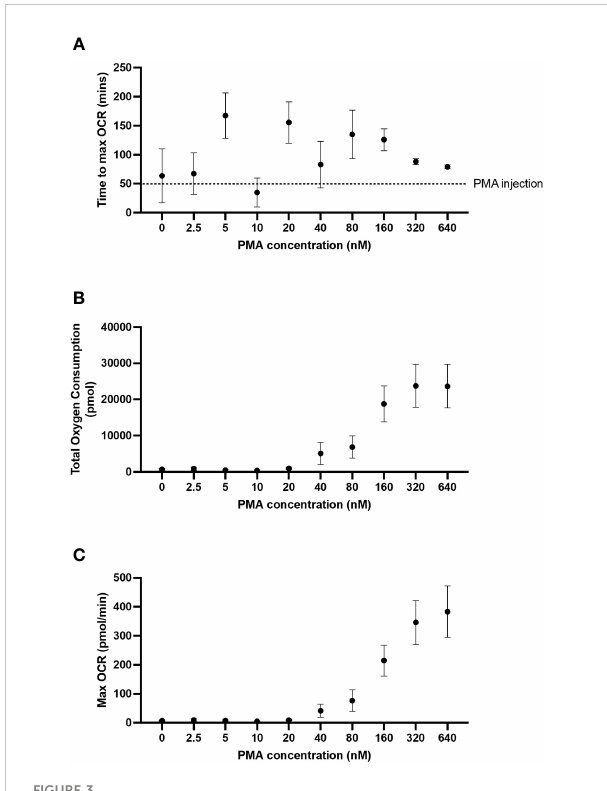
FIGURE 3 PMA-induced OCR from neutrophils. Human peripheral blood neutrophils were seeded at 5 x 10 4 cells/well onto Cell-Tak ™ coated XF XFe96 microplates. Oxidative burst was probed by sequential injection of media, 2 µM rotenone plus 2 µM antimycin A and phorbol 12-myristate 13-acetate (PMA) (640, 320, 160, 80, 40, 20, 10, 5 or 2.5 nM). Oxygen consumption rate (OCR) was monitored over the duration of the test, and results were exported to GraphPad Prism for downstream analysis. Time to max OCR (A) , maximum OCR (B) and total oxygen consumption (C) were calculated from area under the curve analysis. Graphs represent means ± standard error of the mean (SEM) from 5 distinct